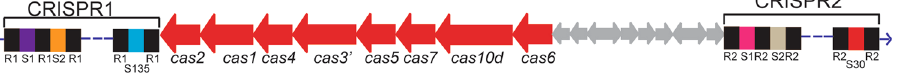
Figure 2. Clustered Regularly Interspaced Short Palindromic Repeats (CRISPR) locus in F. acidiphilum Y T with one operon encoding the CRISPR-associated (Cas) proteins (red arrows). CRISPR system belongs to the Subtype I-D. Ten genes not related to CRISPR are shown in grey. The cluster CRISPR1 contains 137 identical direct repeats of 30 bp separated by 136 different spacers of 34–39 bases. The Cluster CRISPR2 is shorter and has 31 direct repeats (31 bp each) with 30 different spacers (35–62 nt). Spacers and repeats in Clusters 1 and 2 show no sequence similarity one to